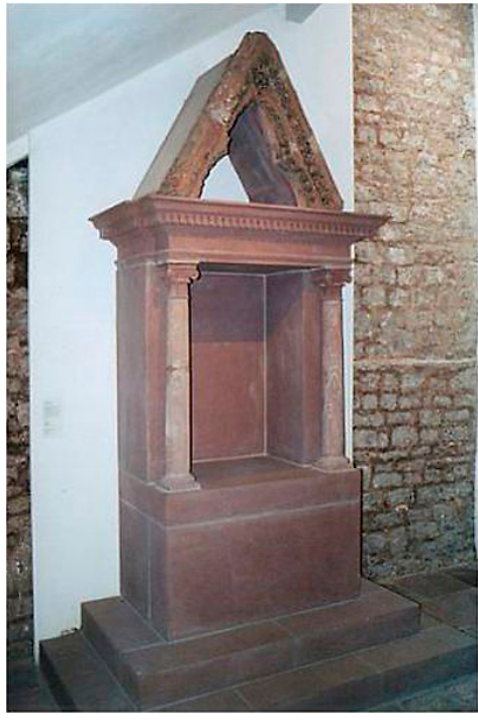
Figure 11. Museum Miltenberg (Alemannia Judaica, used with permission). Arts 2020 , 9 , x FOR PEER REVIEW